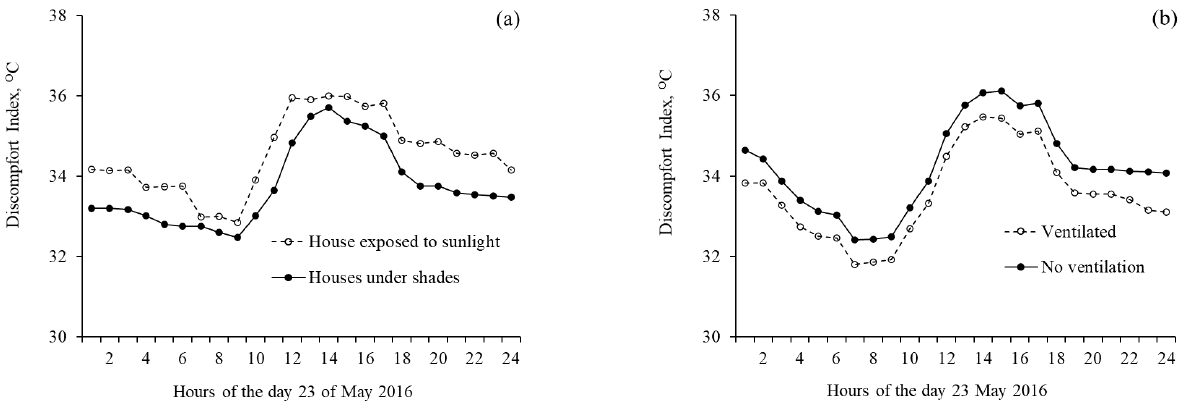
Figure 8. Diurnal effect of the house building design concepts in terms of discomfort indices for 23 May 2016, when people faced the highest discomfort level during summer 2016 under the scenarios of ( a ) houses exposed to sunlight versus shaded houses, and ( b ) houses with and without proper ventilation.